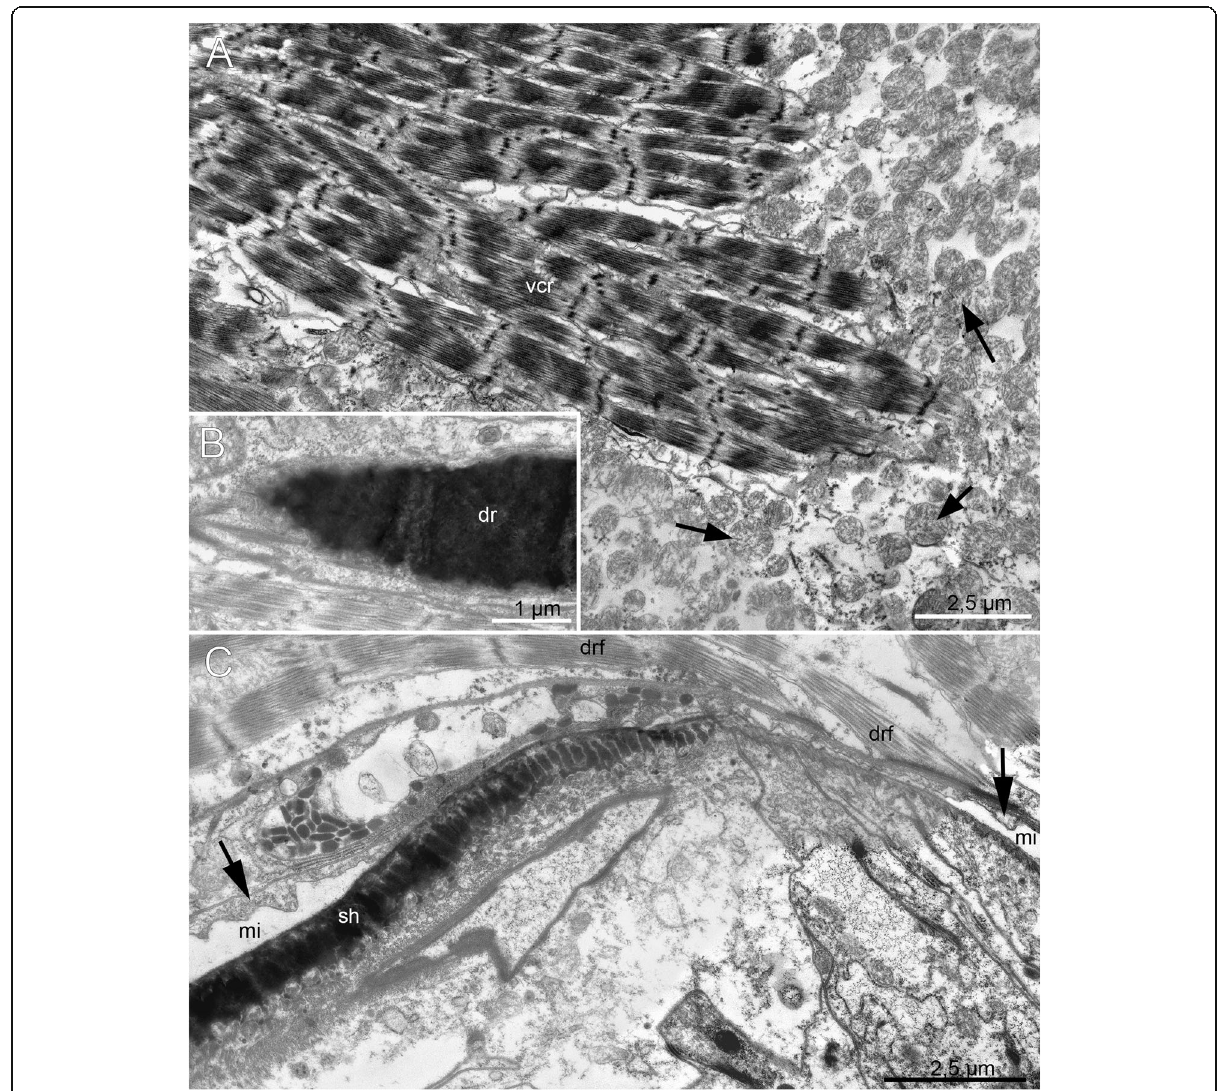
Fig. 6 Fine structure of the ventral pharyngeal organ (VPO) of Histriobdella homari . Parasagittal section, TEM images. a. Ultrastructure of the ventral carrier retractor. Arrows indicate the position of mitochondria. b. Fine structure of the dorsal rod. c. Structure of the posterior zone of the median invagination. Arrows indicate very thin pharyngeal epithelial cells. dr, dorsal rod; drf, dorsal rod flexor; mi, median VPO invagination; sh, mandibular shaft; vcr, ventral carrier